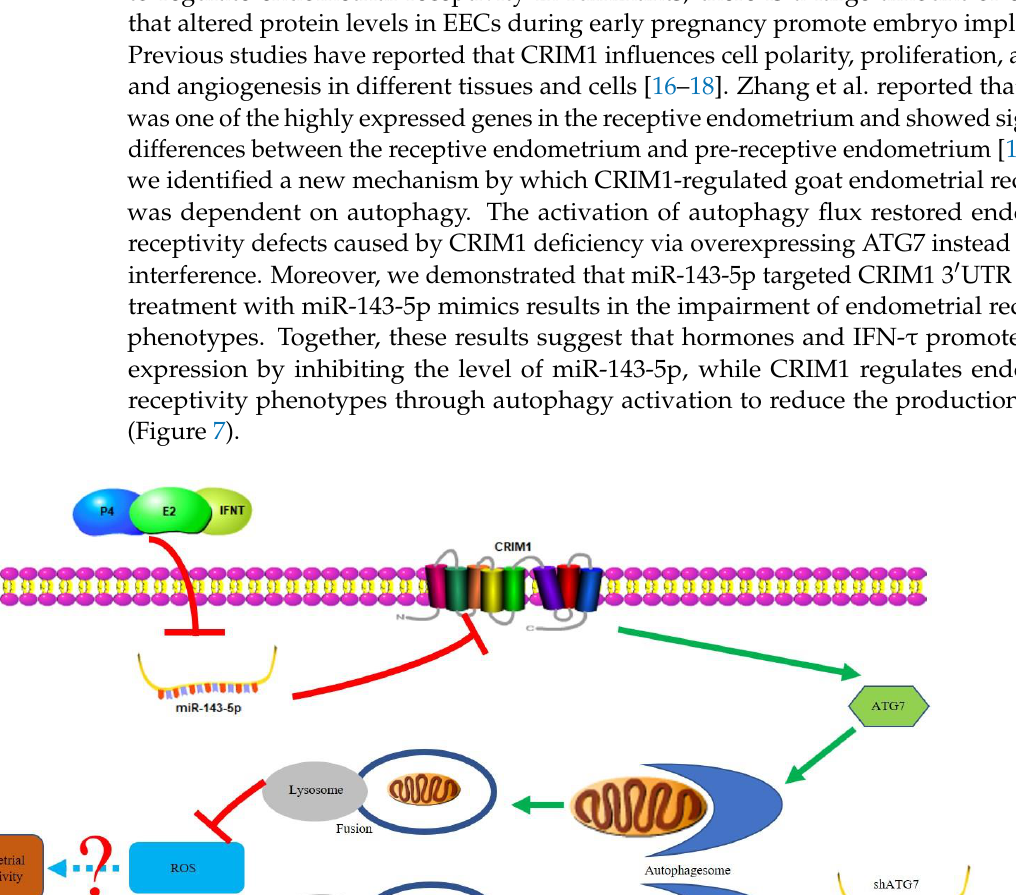
( D ) The luciferase activity was measured by the dual-luciferase reporter assay system. ( E ) The protein level of CRIM1 was measured by Western blot. ( F ) GTC spheroids were prepared and the spheroid attachment rate was measured. Representative images of three independent experiments are shown. Scale bar = 1000 µ m. ( G ) The NC and mimic groups were treated with P 4 , E 2 and IFN- τ for 12 h. The EECs were fixed and processed for SEM analysis. ( H , I ) Fluorescence microscopy images of SPP1 expression in EECs and curves of fluorescence intensity. Representative images of three independent experiments are shown. Scale bar = 100 µ m. ( J ) The cell adhesion molecules were measured by real-time quantitative PCR. ( K ) The secretion levels of PGE 2 and PGF 2 α were measured in EECs using an ELISA kit. ( L ) The rate-limiting enzymes of synthesized PGs were measured by real-time quantitative PCR. The data are presented as the means ± SEM of three independent experiments. * Significant difference ( p < 0.05) compared with other groups; ** Significant difference ( p < 0.01) compared with other groups.